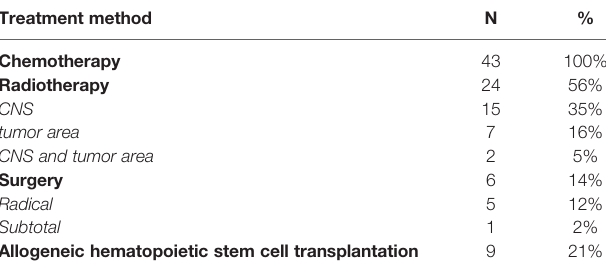
TABLE 3 | Methods of MS treatment in the study